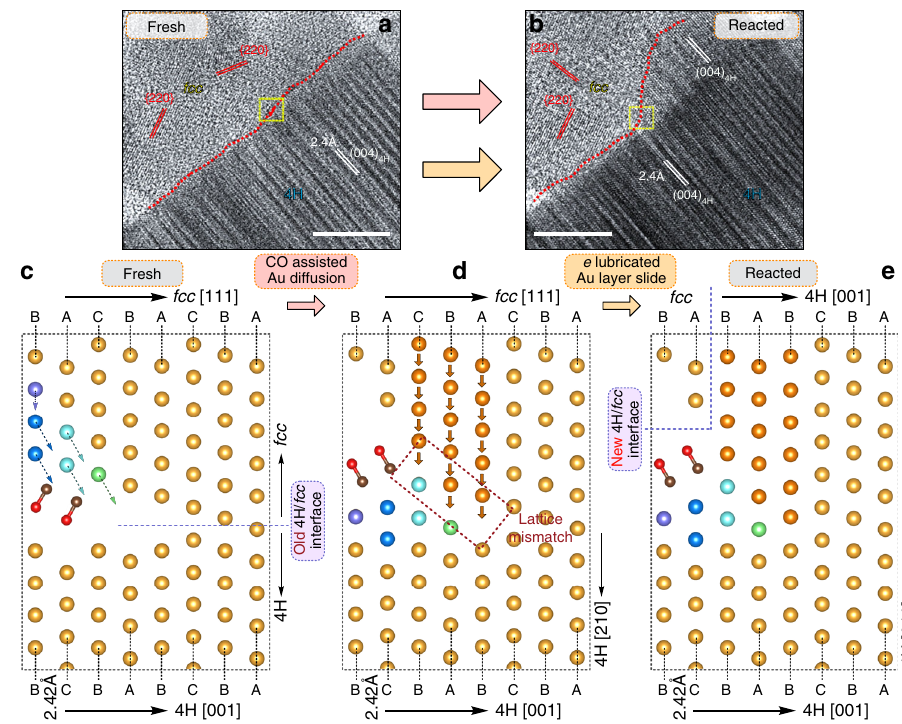
Fig. 6 Schematic reaction mechanism of the epitaxial growth. HRTEM image showing the propagation between the fcc crystal lattices of the nanoparticles and 4H phase of the rod region before ( a ) and after ( b ) reaction. Both the scale bars in panel a – b corresponds to 5 nm. Please note that the interface between the 4H and fcc phases are labeled by the red dashed lines. c – e The atomic models schematically showing the fcc -to-4H transformation